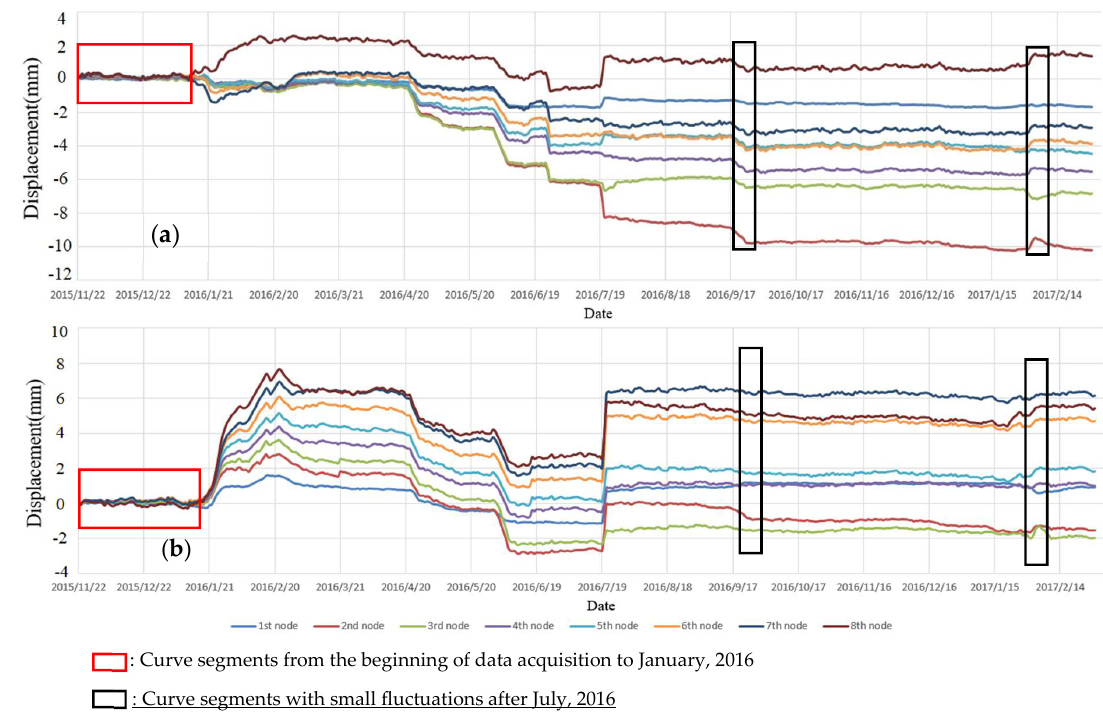
Figure 6. Curves of cumulative horizontal displacement in the X and Y directions of the 4 m-long SAA. ( a ) Curves of cumulative horizontal displacement in the X direction of the 4 m-long SAA; ( b ) Curves of cumulative horizontal displacement in the Y direction of the 4 m-long SAA.